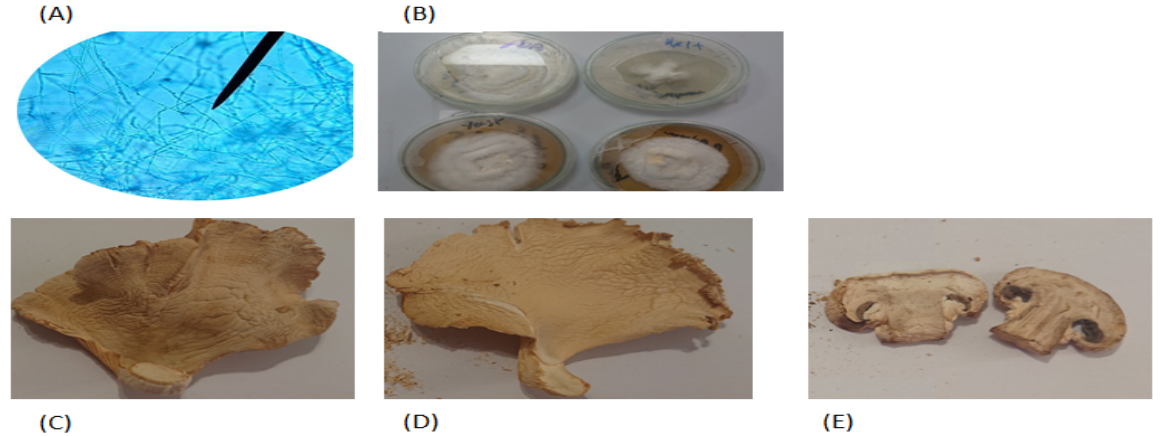
Figure 1. ( A ) Microscopic examination of the white rot fungus using light microscope, ( B ) growth of mushroom on potato dextrose agar post 7 days culture. Dried fruiting bodies of the collected mushroom isolates, ( C ) Pleurotus columbinus , ( D ) Pleurotus sajor-caju , and ( E ) Agaricus bisporus.